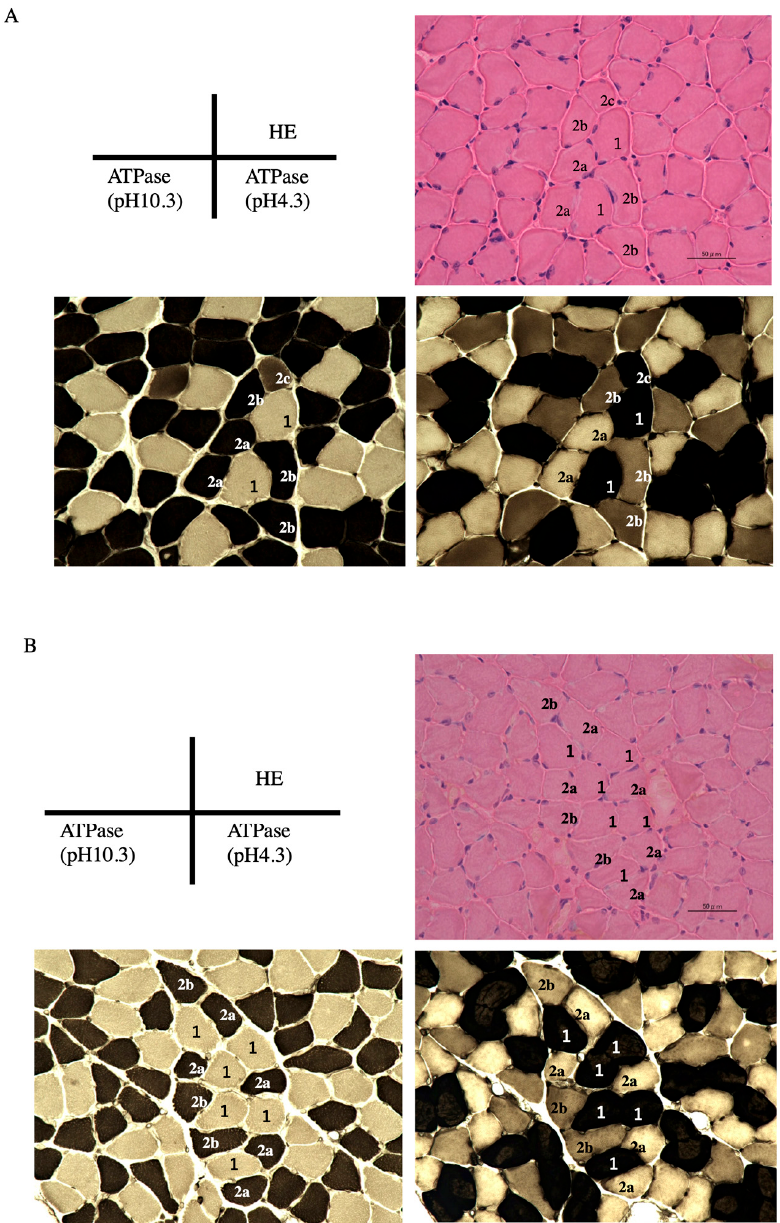
Figure 3. Histological analysis of the soleus muscle. Muscle fiber typing was performed by determining myosin ATPase activity; ATPase activity at pH 4.3 is associated with type 1 fibers and ATPase activity at pH 10.3 is associated with type 2 fibers. ( A ) Control group; ( B ) WRS group. The muscle fibers in the WRS group had thinner cross sections and contained fewer type 2b fibers than those in the control group. The scale bar indicates 50 mm. Table 4. Muscle fiber typing and cross-sectional area of soleus.